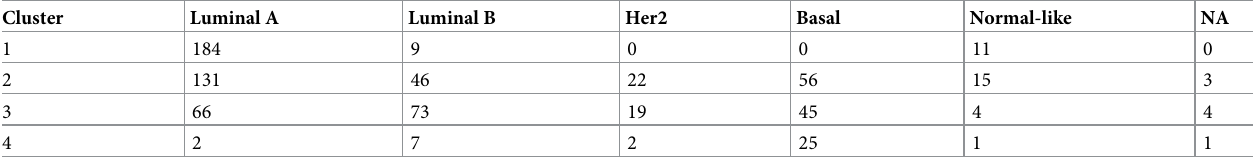
Table 3. Comparison between PAM50 subtypes and clusters identified by the proposed method.